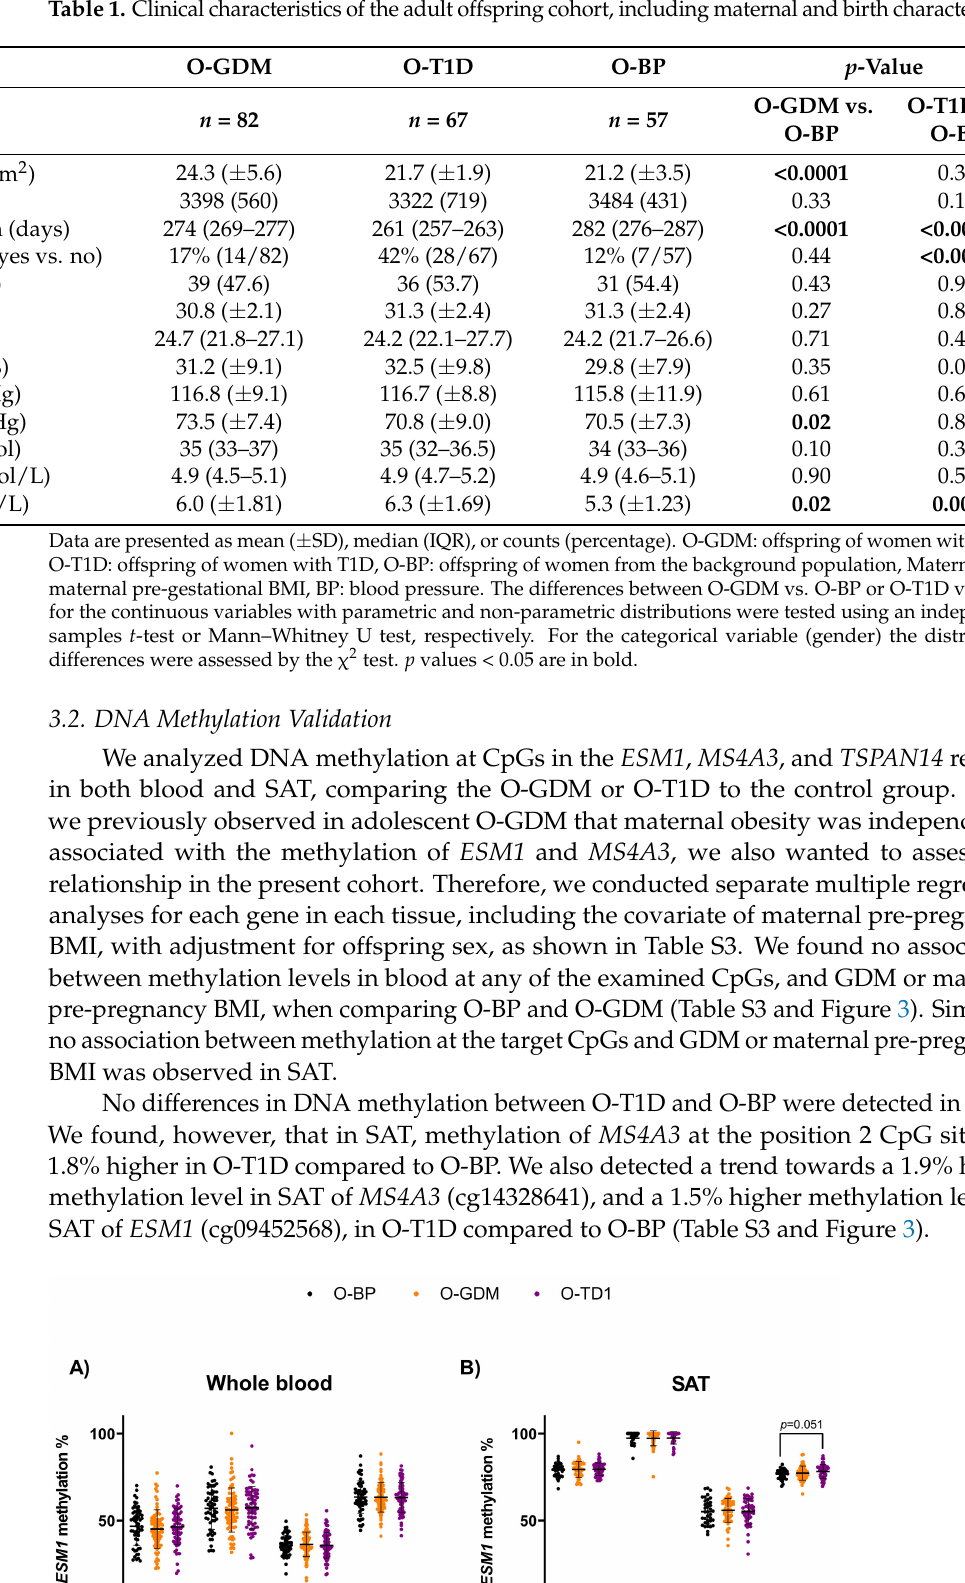
Table 1. Clinical characteristics of the adult offspring cohort, including maternal and birth characteristics.